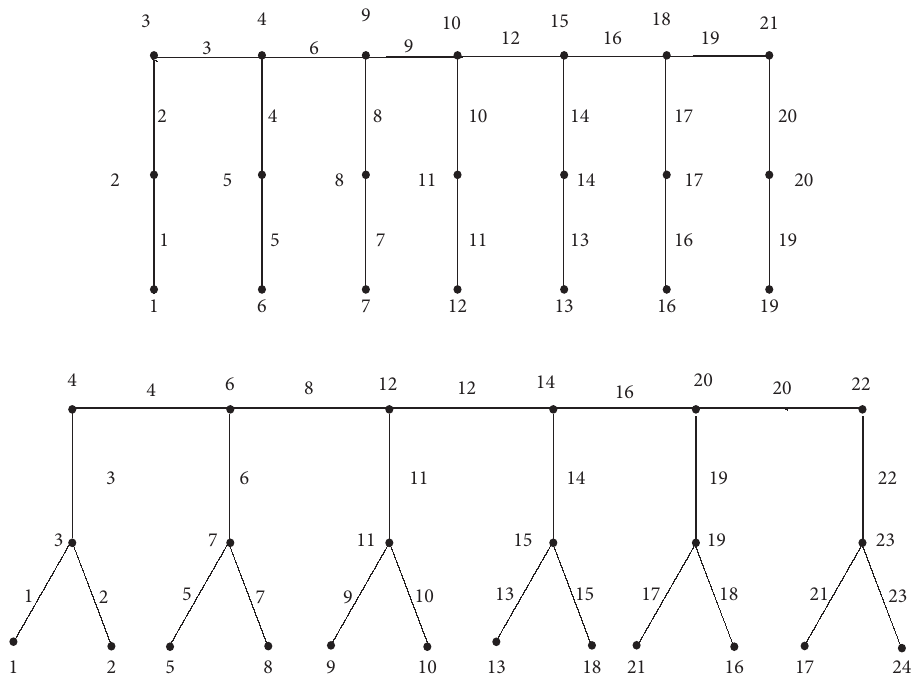
Figure 5: A classical mean labeling of [ P